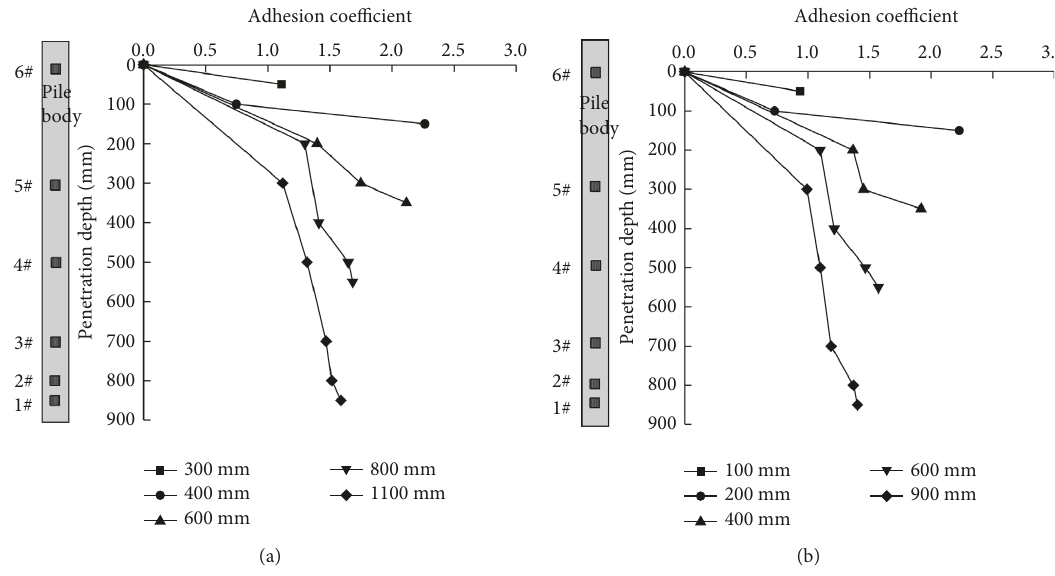
Figure 7: Change trend of adhesion coefficient of the pile-soil interface during pile jacking process: (a) TP1, (b)